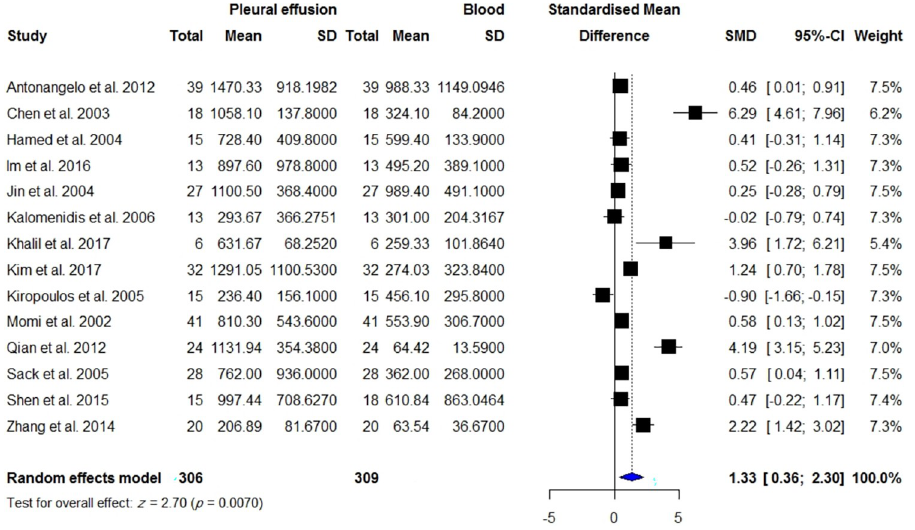
Fig 10. Meta-analysis of pleural VEGF levels vs. blood VGEF levels in the same patients with TPE.